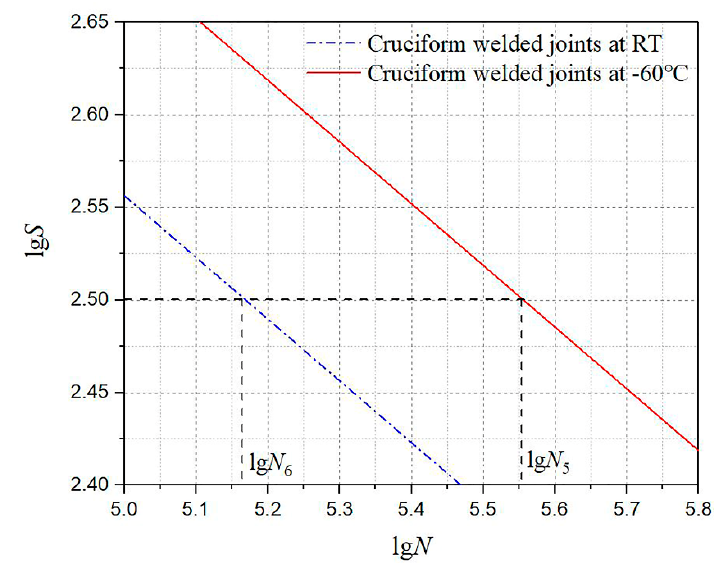
Figure 16. The logarithmic S-N curves of cruciform welded joints at room temperature and − 60 °C.